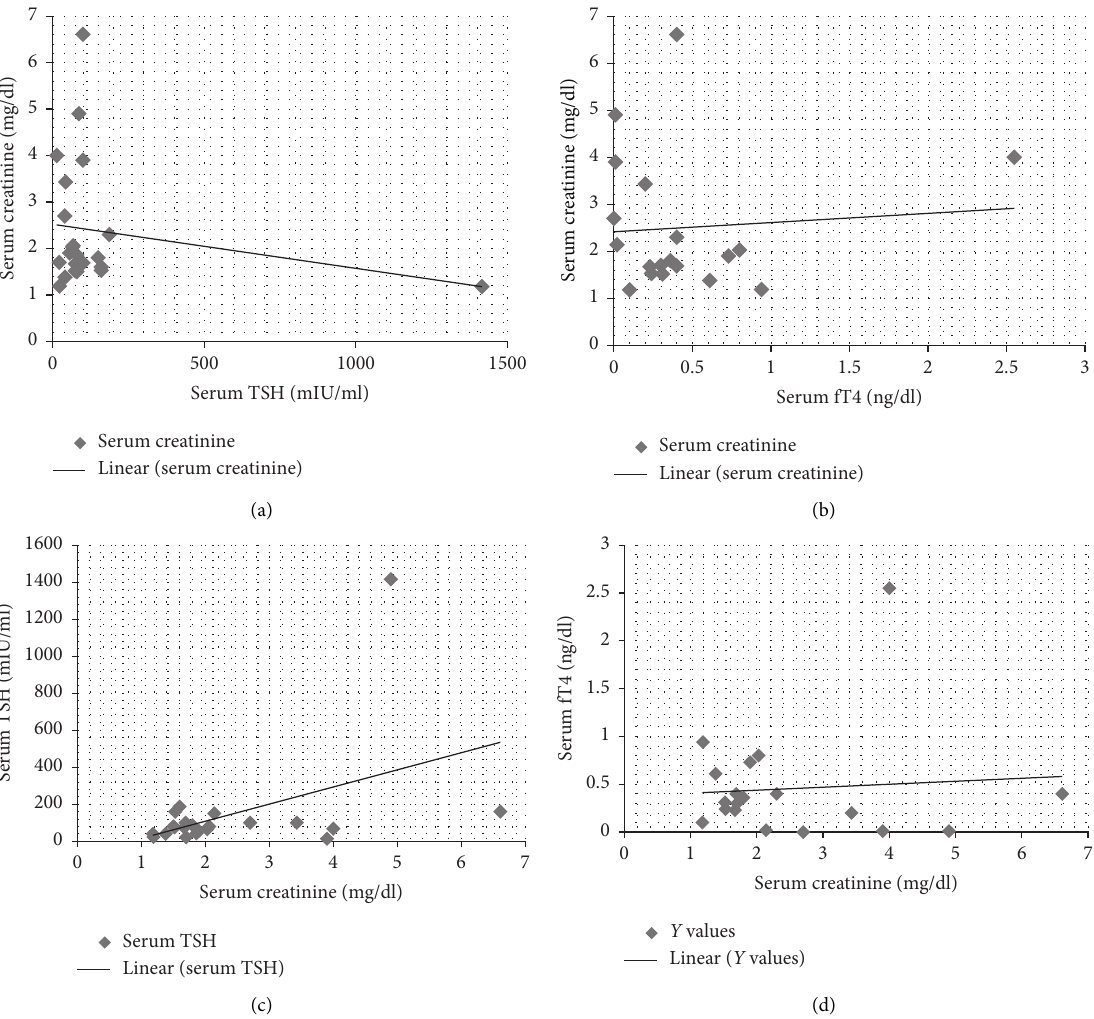
Figure 5: Correlation between serum TSH, fT4 levels, and serum creatinine in the present study. (a, b) Impact of thyroid dysfunction on kidney function test in primary hypothyroidism. (c, d) Impact of kidney dysfunction on elevated TSH and decreased fT4 in primary hypothyroidism. fT4, free thyroxin; TSH, thyroid-stimulating